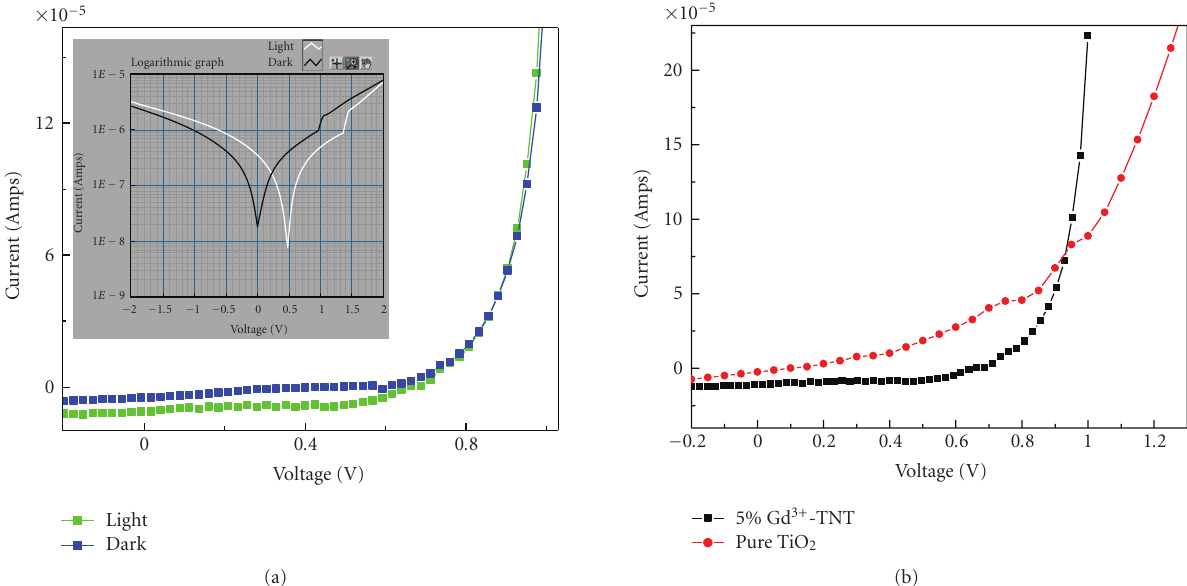
Figure 7: (a) Dark and Light IV curves of 5% Gd 3+ -TNT/PTEBS hybrid polymer solar cell; (b) IV curves of pure TiO 2 and 5% Gd 3+ -TNT hybrid solar